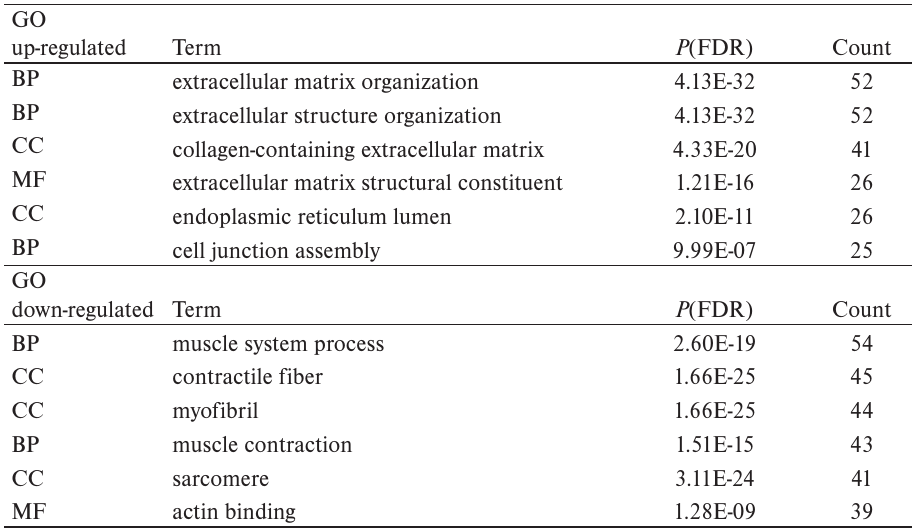
Table 2. Enrichment analysis of GO in DEGs.